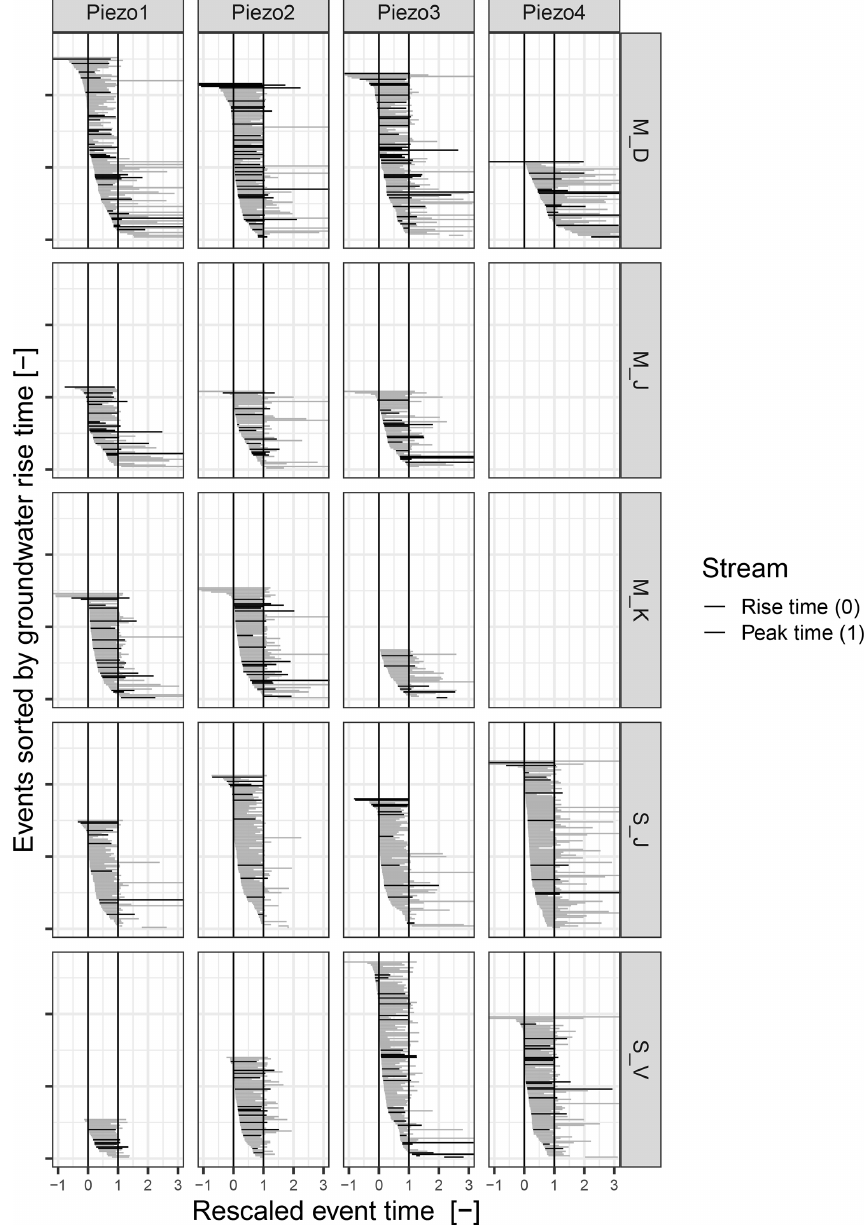
Figure B2. Timing of groundwater response relative to stream response. Black events are from 2015, while grey events are from all other years. (Replotting of Fig. 9 to visualize the effect of a reduced (1-year) observation